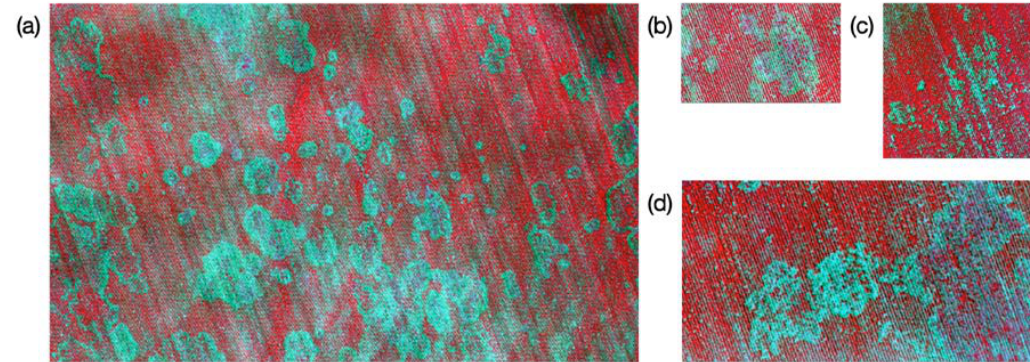
Figure 5. Multispectral color-infrared (CIR) images for ( a ) Region ‘CH1’ (Scale 1:3000), ( b ) Region ‘CH2’ (Scale 1:2000), ( c ) Region ‘WP’ (Scale 1:2400), and ( d ) Region ‘SH’ (Scale 1:3800). The regions are shown in di ff erent scales for a better visualization of